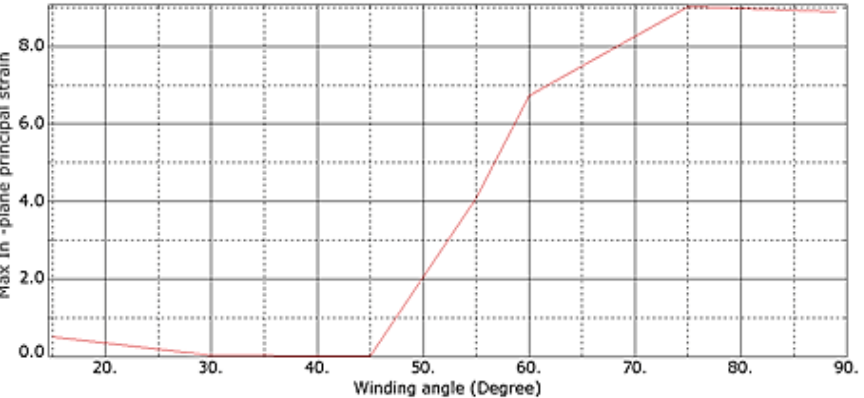
Figure 17. Variation of maximum principal strain with winding angle increase.